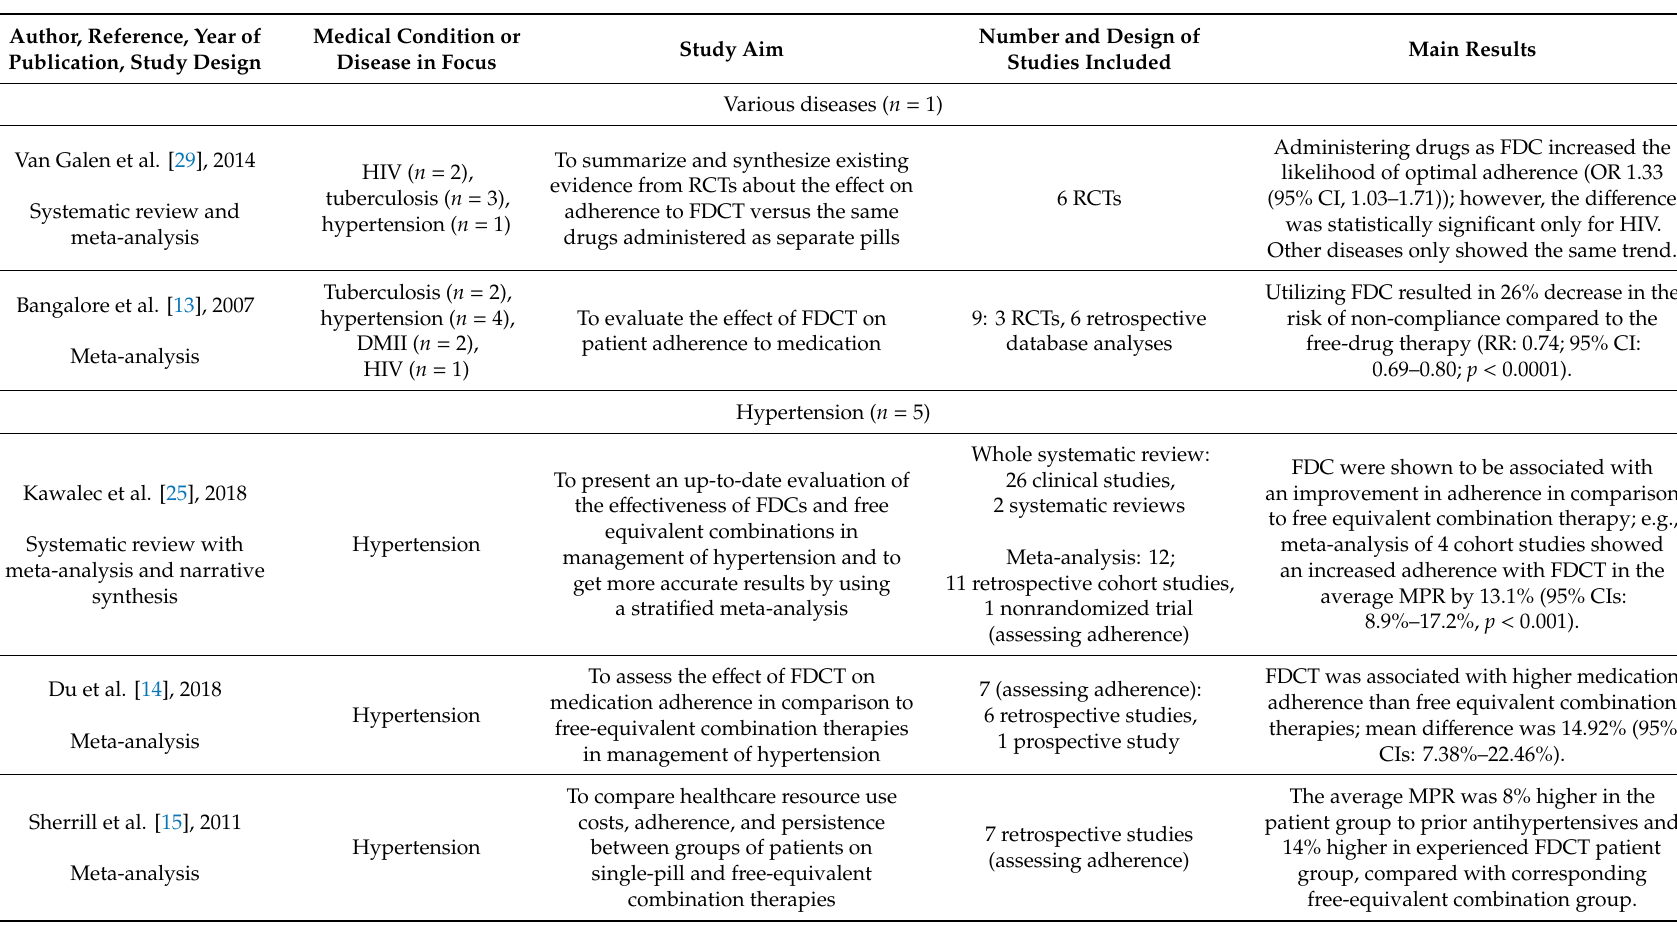
Table A1. Summary of the systematic reviews and meta-analyses ( n = 17) regarding the medical condition in focus, study aim, number and design of included studies, and main